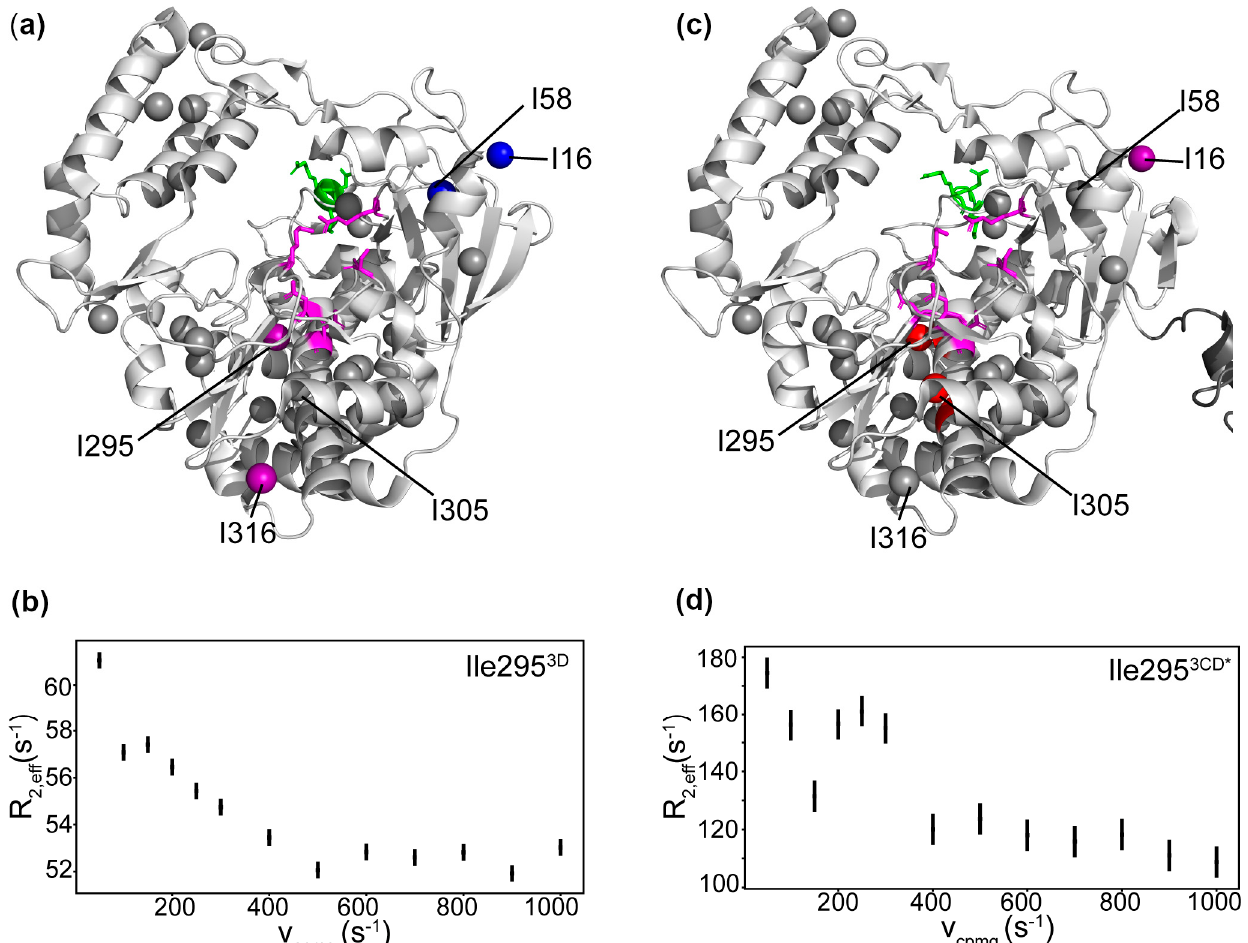
Figure 7. Conformational exchange processes in 3D and the 3D domain of 3CD on the µ s-ms timescale. ( a ) R ex , the contribution to transverse relaxation from conformational exchange, from multiple quantum 1 H- 13 C CPMG relaxation dispersion for 3D plotted as colored spheres (gray: no detectable exchange, blue < 2–3 s − 1 , purple: 3–10 s − 1 ). ( b ) Multiple quantum 1 H- 13 CHHHH CPMG relaxation dispersion curve for Ile295 in 3D. ( c ) R ex from multiple quantum 1 H- 13 C CPMG relaxation dispersion for 3CD plotted as colored spheres (gray: no detectable exchange, purple: 3–10 s − 1 , red > 10 s − 1 ). ( d ) Multiple quantum 1 H- 13 CHHHH CPMG relaxation dispersion curve for Ile295 in the 3D domain of 3CD. 3D numbering is used here for both 3D and the 3D domain in 3CD; to find the corresponding number in 3CD, the reader would need to add